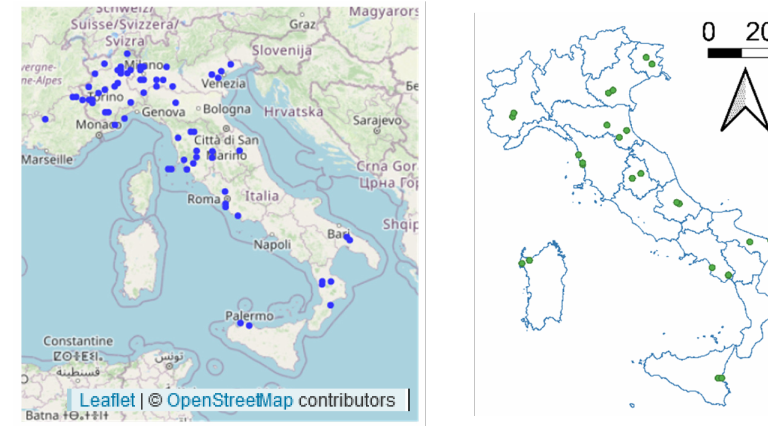
Example of distribution of